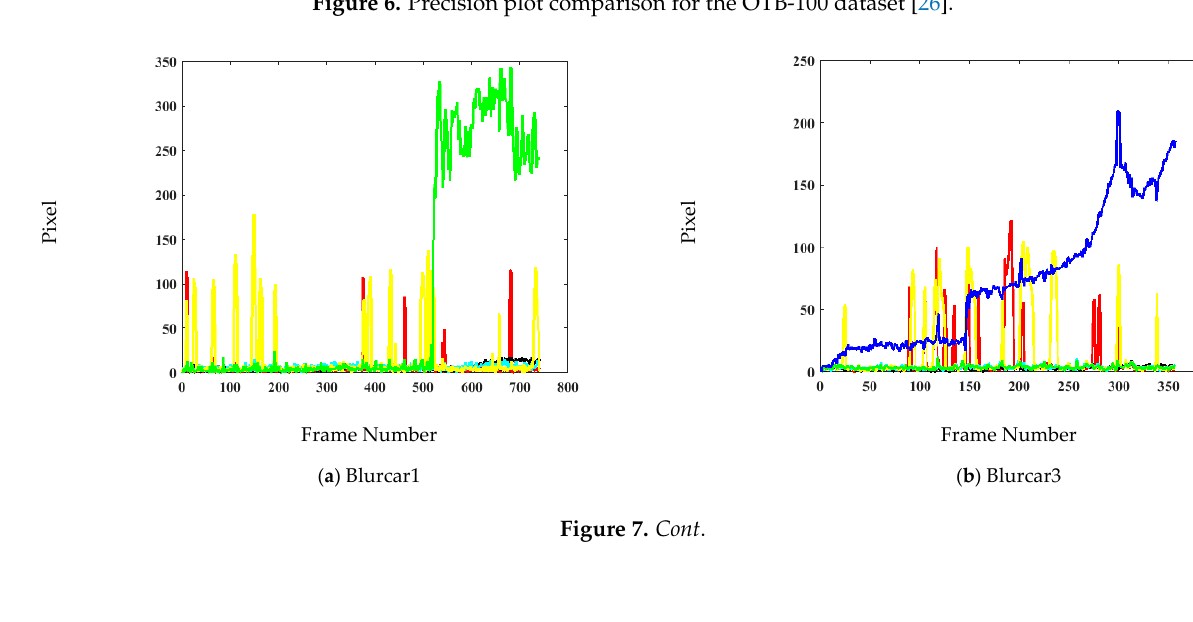
Figure 6. Precision plot comparison for the OTB-100 dataset [26].